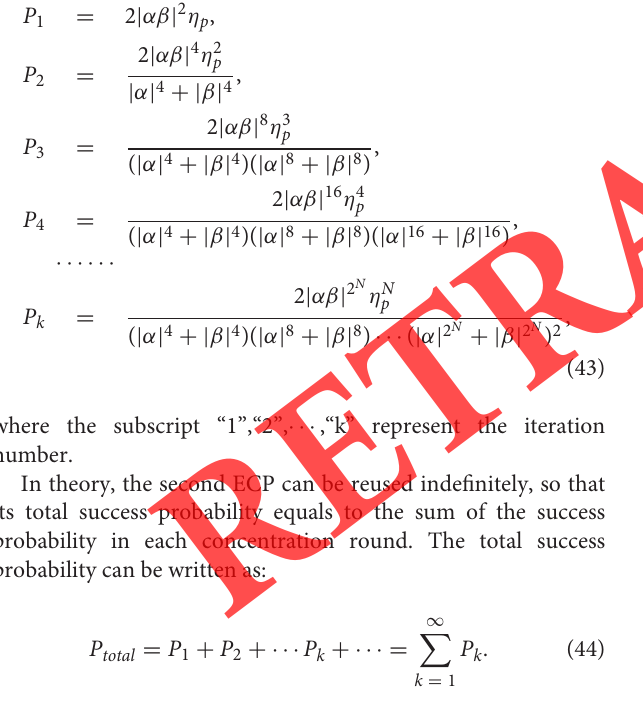
FIGURE 4 | The total success probability (P total ) of our second ECP altered with the initial entanglement coefficient α . As the second ECP can be repeated, we choose its iteration time k 1,3,5 for numerical = simulation. The success probability of the first ECP equals to P total with k 1. = Considering the effect of the single photon detection efficiency ( η p ) on the P total , we suppose η p 90 % for =